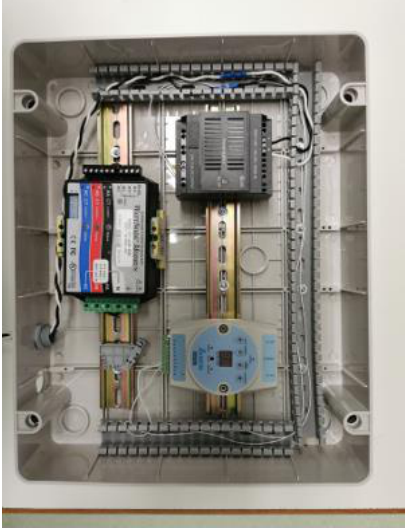
Figure 11. The Hybrid Station. The top figure shows the single line diagram of PV-Battery, while the bottom figure shows how the WattNode and IFD9507 converter are interfaced to the hybrid